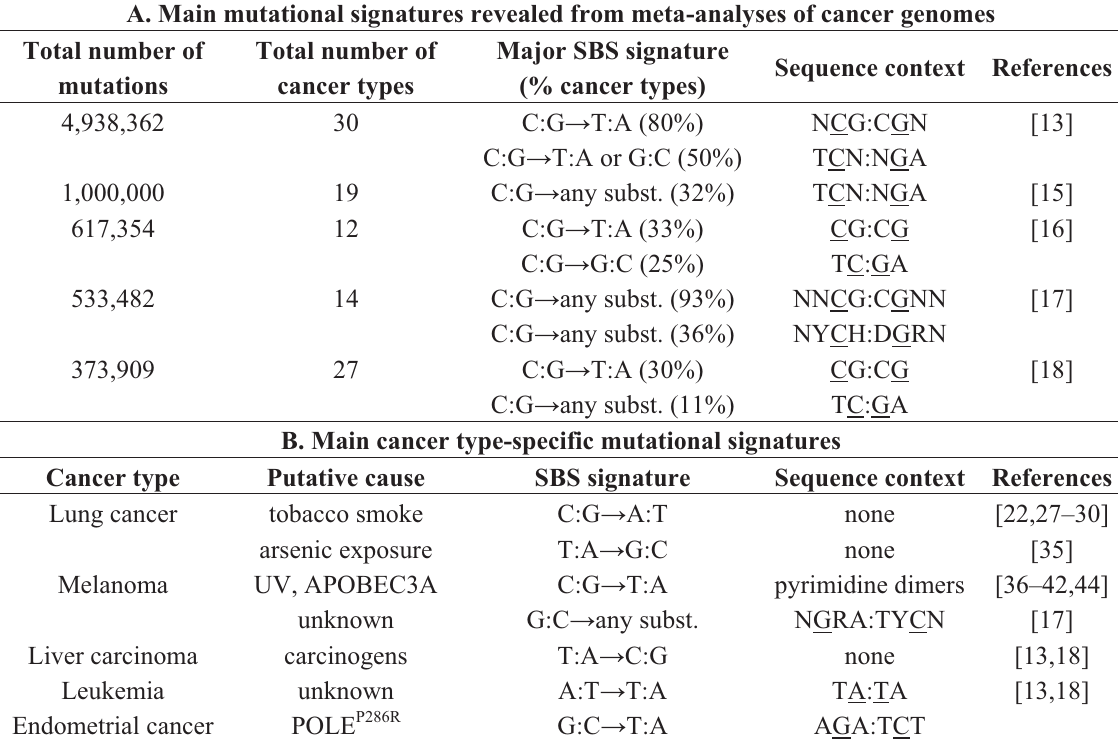
Table 1. Mutational signatures in cancer